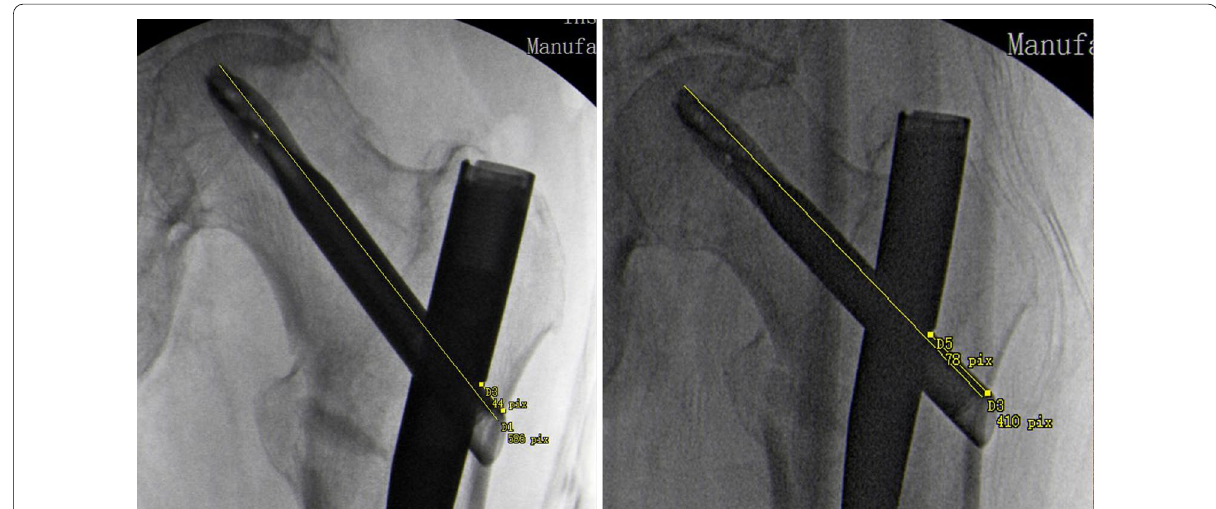
Fig. 2 Depicted is the technique for measuring proximal femoral shortening as described by Serrano et al. The measurements taken from the drawn lines are compared with the length of the helical blade. The proximal femur has shortened 1.2 cm from the images obtained during the initial procedure (left) to images obtained 12 days later (right)